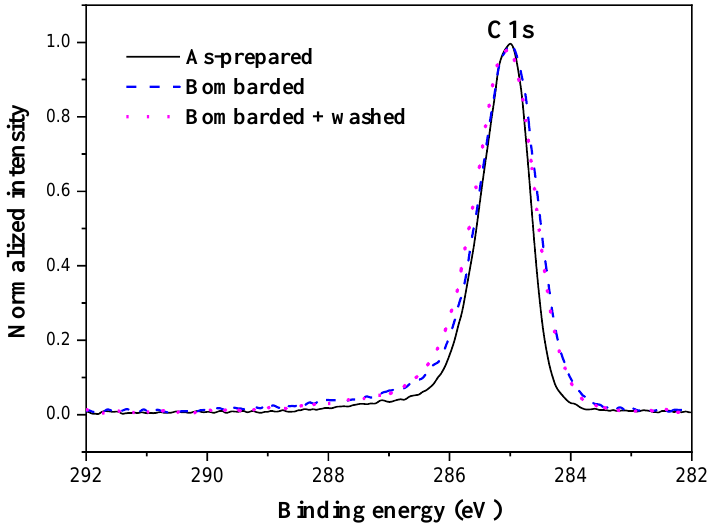
Figure 5. Comparisons of C1s of C 32 H 66 thin films prepared at the concentration of 0.3% w/v after hyperthermal hydrogen bombardment, indicating increase in peak width after cross-linking induced by the bombardment.